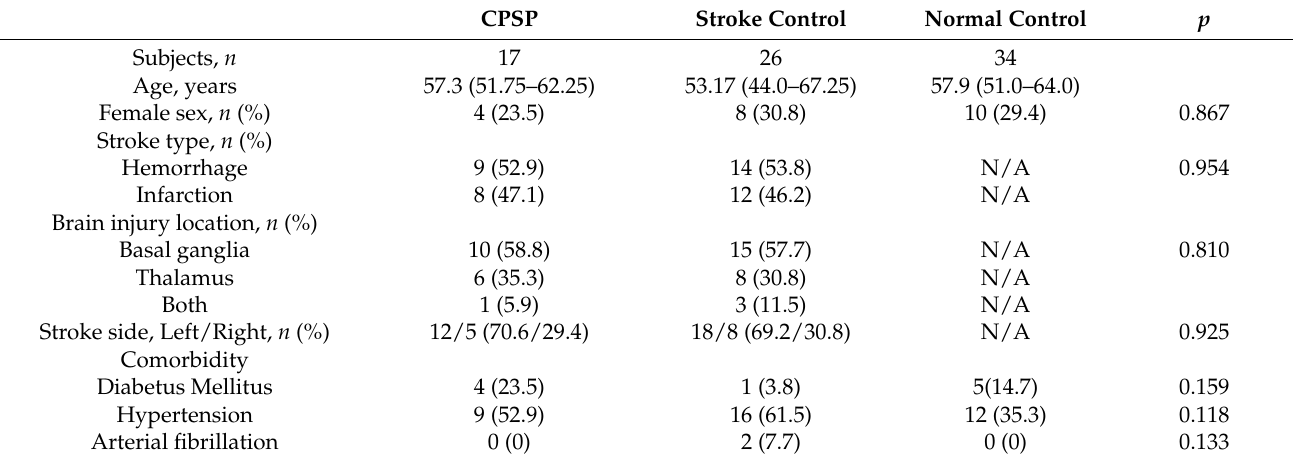
Table 1. Participants’ demographic